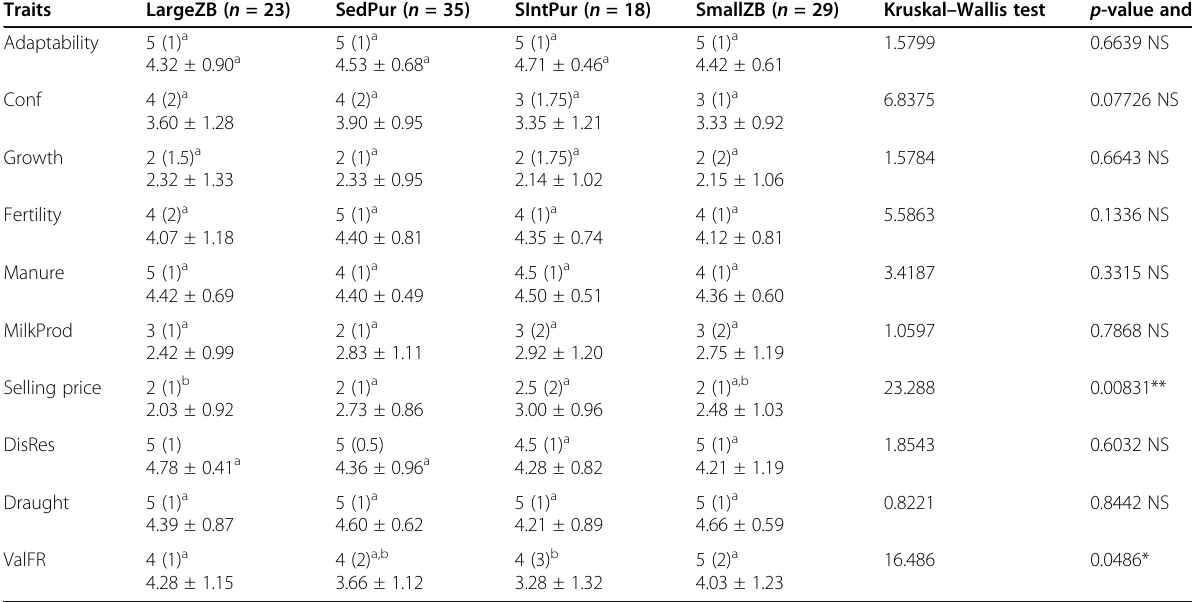
Table 3 Functional traits in the Borgou cattle breed according to groups of farmers Traits